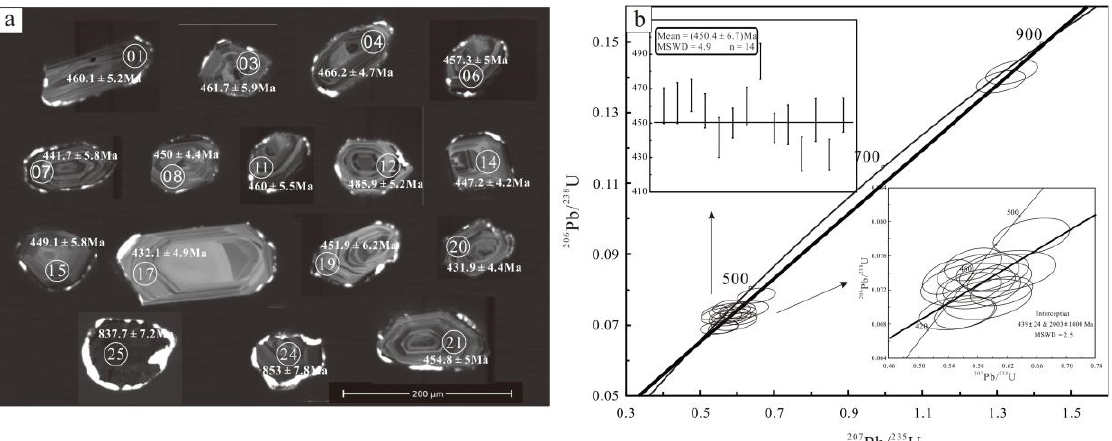
Figure 6. ( a ) Representative cathodoluminescence images of zircons obtained from cassiterite (ore specimen PA01) from the Ping’an Pb–Zn–Cu deposit. White circles with numbers indicate spots